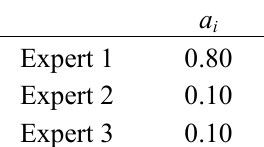
Table 4. Weights for the experts (n =